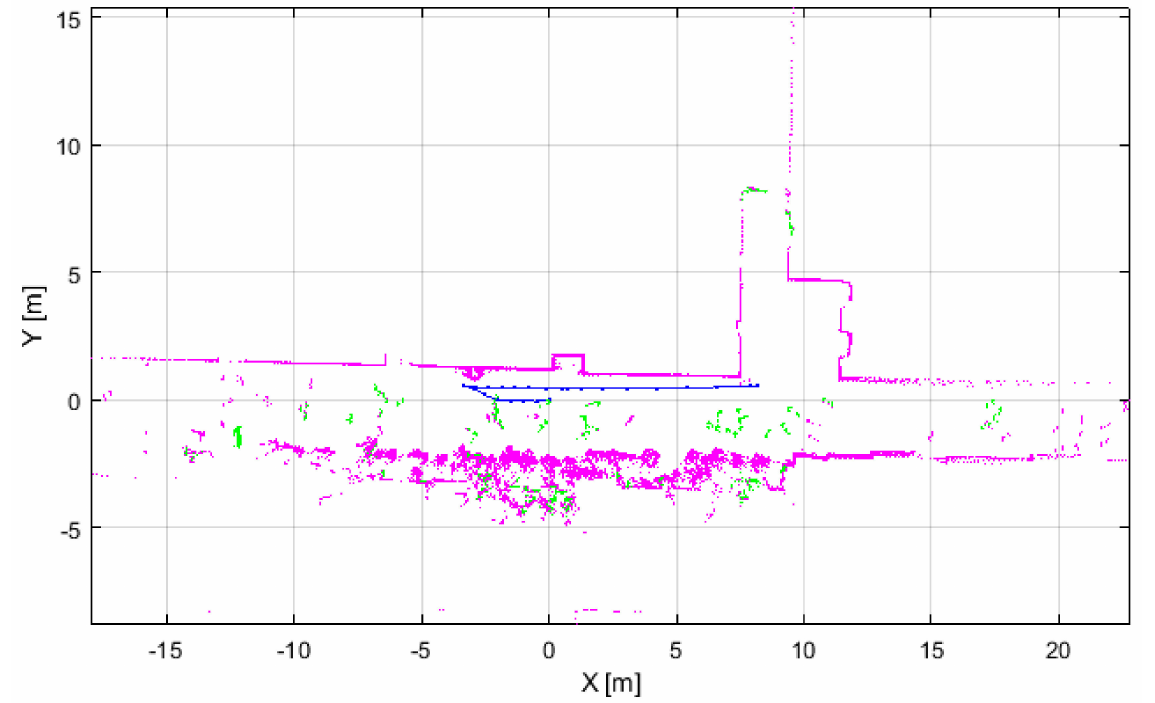
Figure 18. ASLAM execution and detection of dynamic objects in